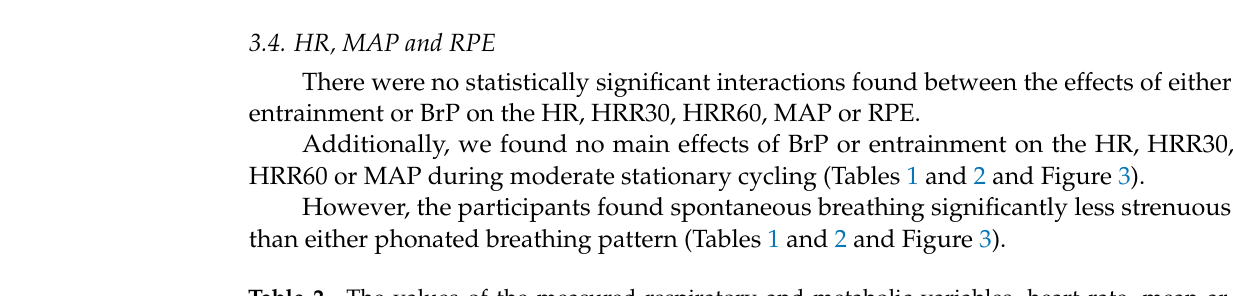
Table 2. The values of the measured respiratory and metabolic variables, heart rate, mean ar- terial blood pressure and RPE during moderate aerobic exercise based on different BrPs and entrainment